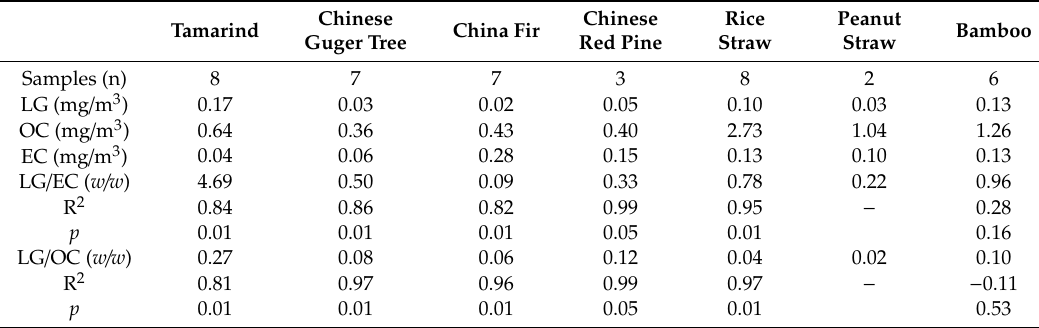
Table 3. OC, EC, and LG concentrations, as well as LG / EC and LG / OC ratios in smoke particles derived from di ff erent biofuel species.